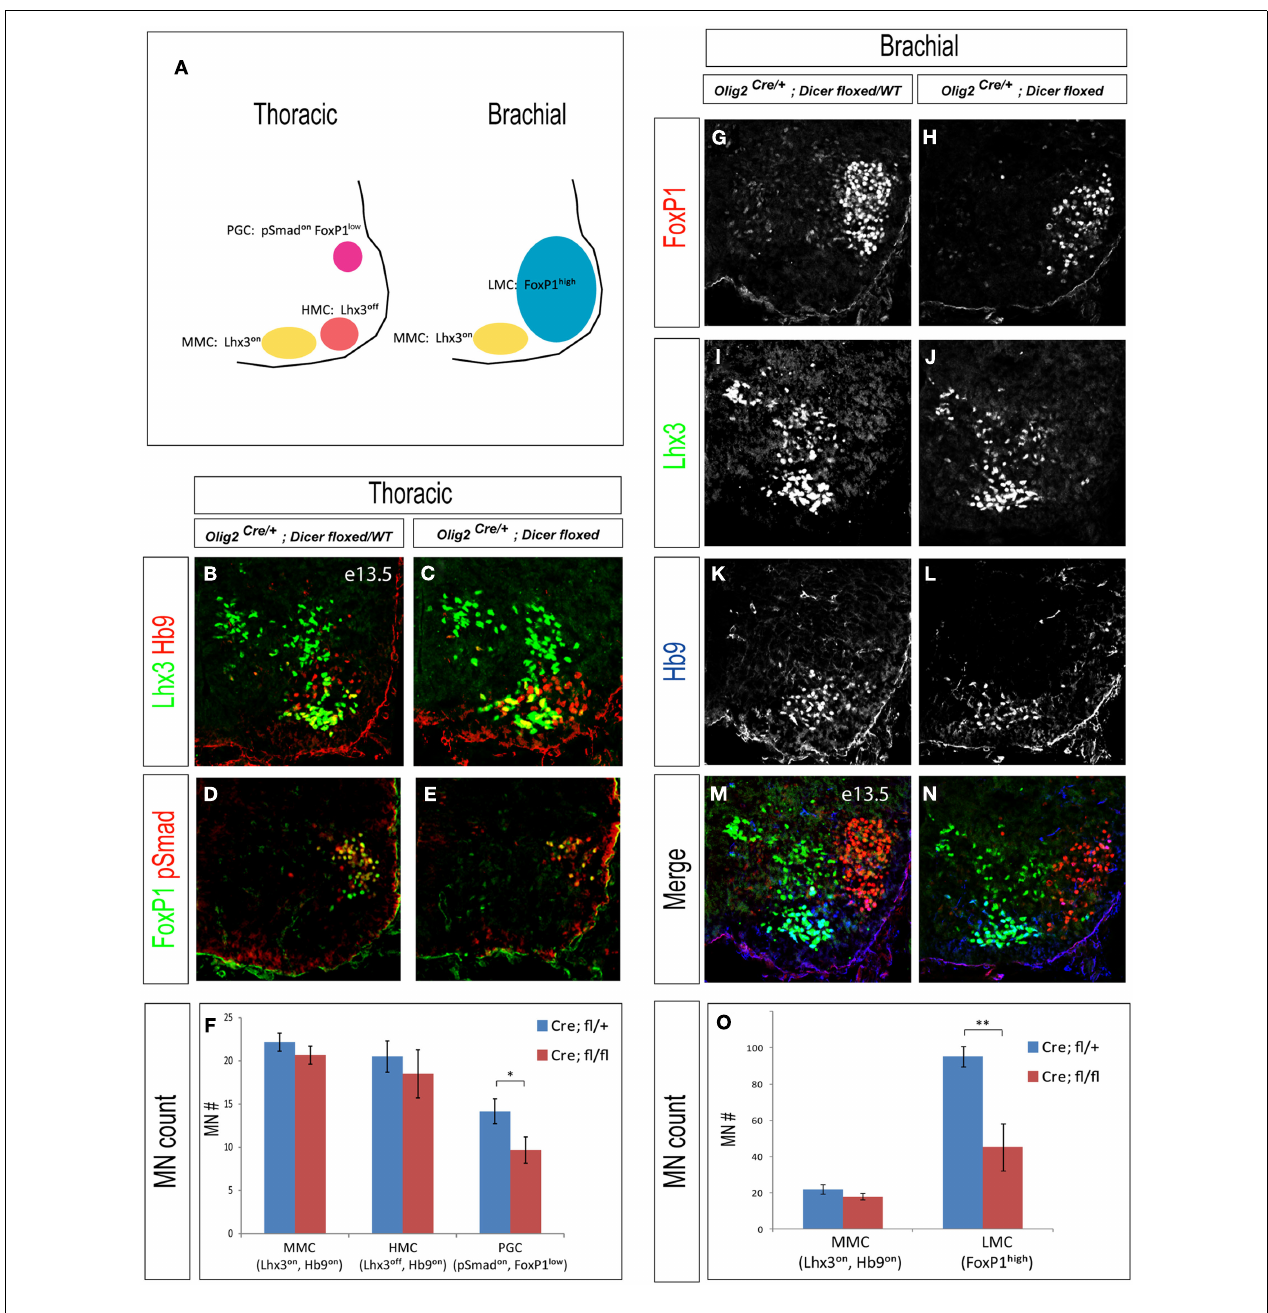
in the thoracic spinal cord sections of E13.5 conditional Dicer mutant embryos. In contrast, the numbers of MMC (Lhx3 on , Hb9 on ) and HMC (Lhx3 off , Hb9 on ) motor neurons are not affected. (G–N) Immunostaining of brachial spinal cord sections reveals a decrease of LMC (FoxP1 high ) motor neurons in E13.5 conditional Dicer mutant embryos, whereas MMC (Lhx3 on , Hb9 on ) motor neurons are not affected. (F,O) Quantification of PGC (pSmad on , FoxP1 low ), HMC (Lhx3 off , Hb9 on ), LMC (FoxP1 high ), and MMC (Lhx3 on , Hb9 on ) motor neurons (number of positive cells per 15 μ m brachial or thoracic spinal cord hemisection) in control and conditional Dicer mutant embryos, mean ± SD reveals a significant decrease in the number of PGC and LMC motor neurons (* p < 0.05; ** p < 0.01). N = 3